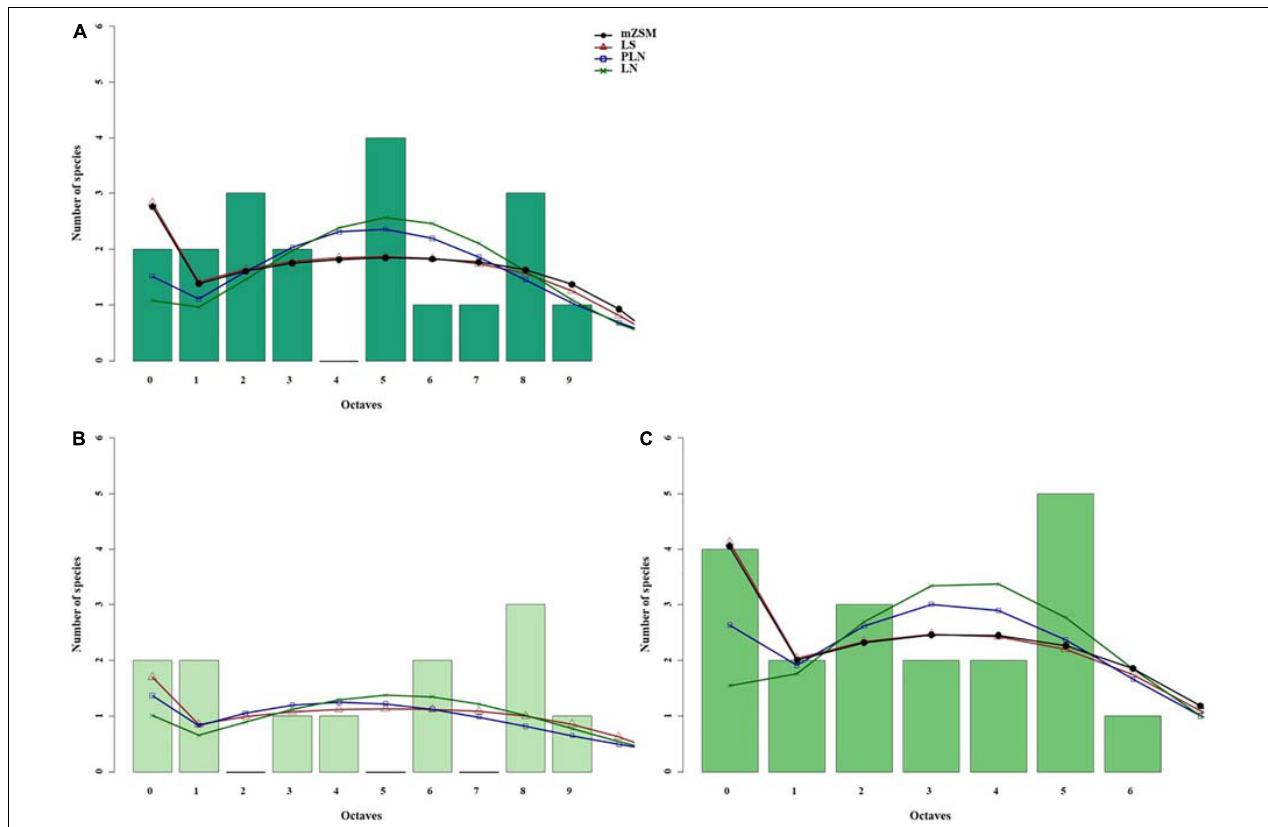
FIGURE 3 | Species abundance distribution (SADs) of carabid beetles in a Chinese meadow steppe. SADs were modeled using the lognormal (LN), the Poisson-lognormal (PLN; zero-truncated version), the Fisher log-series (LS), and the metacommunity Zero-Sum Multinomial (mZSM) distributions. Analyses were done for the whole steppe (A) and two different sectors separately [ (B) ms1 sector, (C) ms2 sector]. Distributions were fitted to the raw abundance data (i.e., not binned). The data were binned for graphical comparison with gambin models, which require